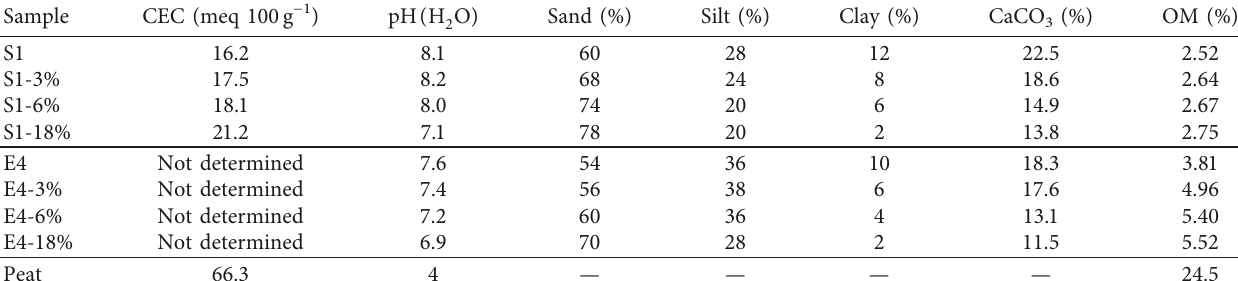
Table 1: Physicochemical characteristics of original and amended soils and commercial peat.